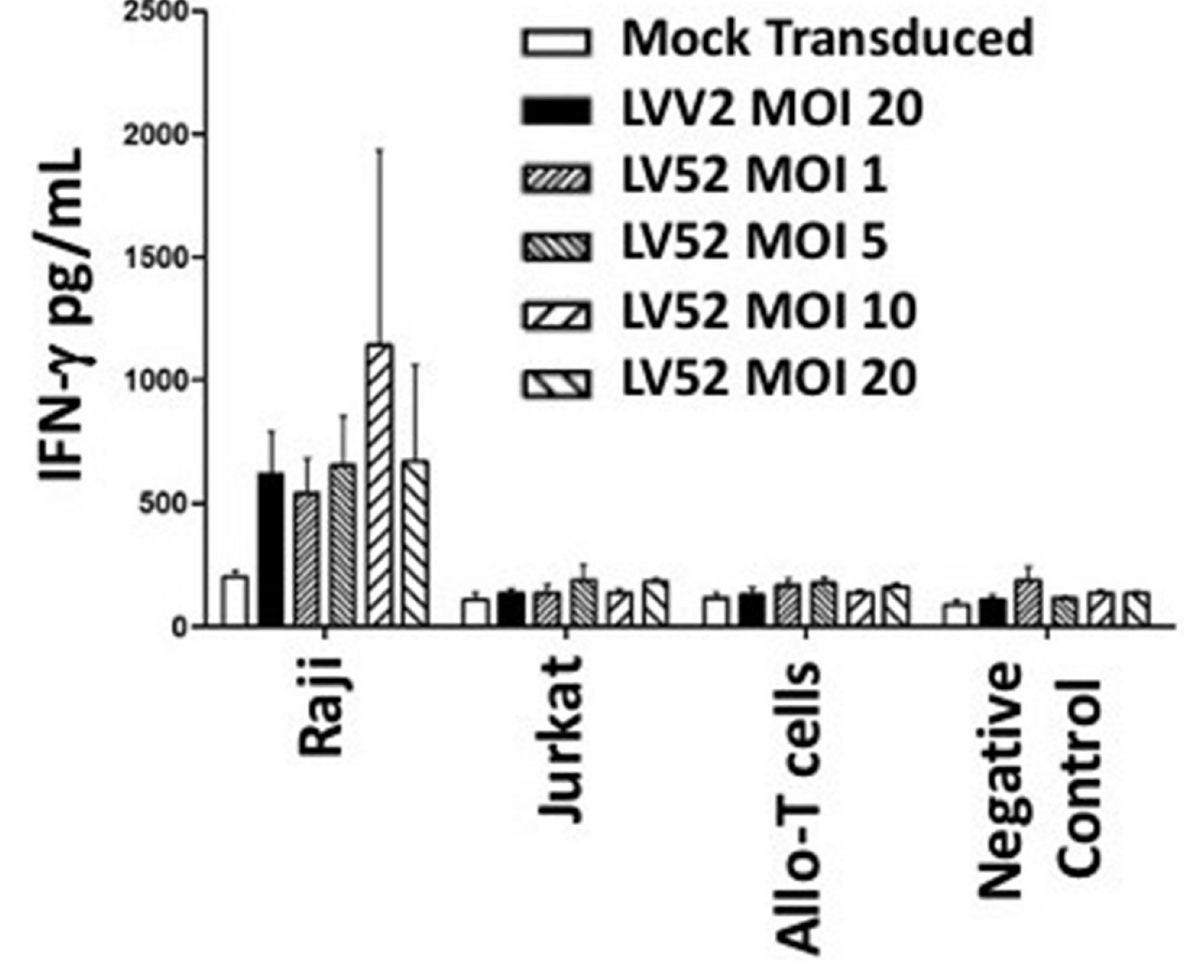
Fig 5. IFN- γ production by CAR-CD19 T cells. The concentration of IFN- γ in culture supernatants following 24 hours of co-culture between the indicated cell types and mock transduced or T cells transduced with LVV2 or LV52 at the indicated MOI using LEGENDplex ™ . The data shown are the mean ± SEM of 3 independent